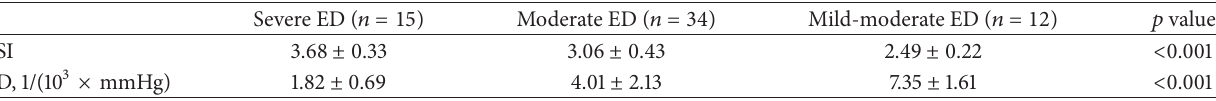
Table 3: The relation of pretreatment erectile dysfunction severity with aortic elasticity.